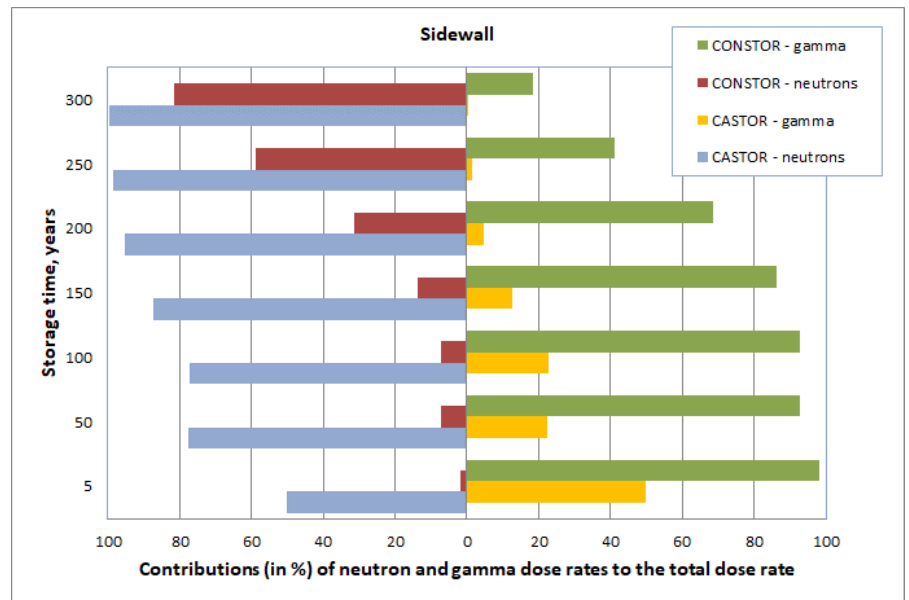
Figure 6. Neutron ( left ) and gamma ( right ) inputs to the total dose rate: side of the containers.